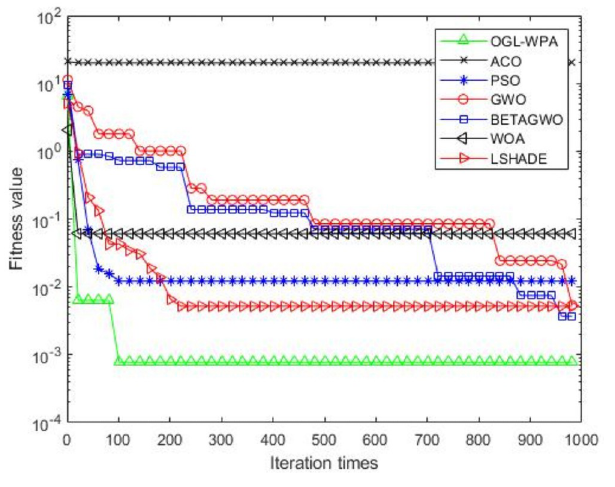
Fig 9. F8 iteration